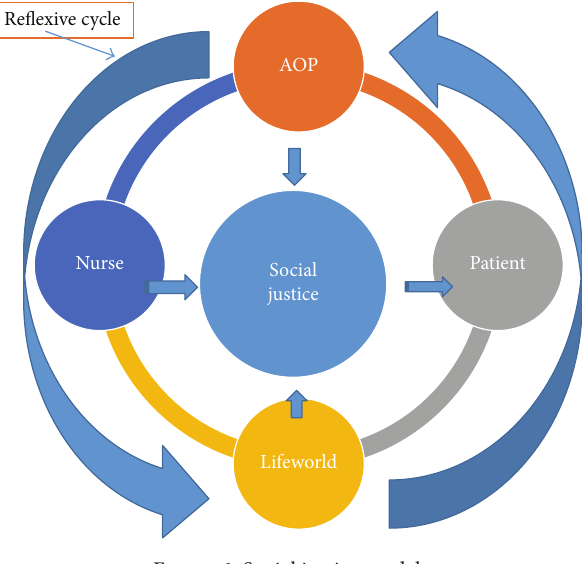
Figure 1: Social justice